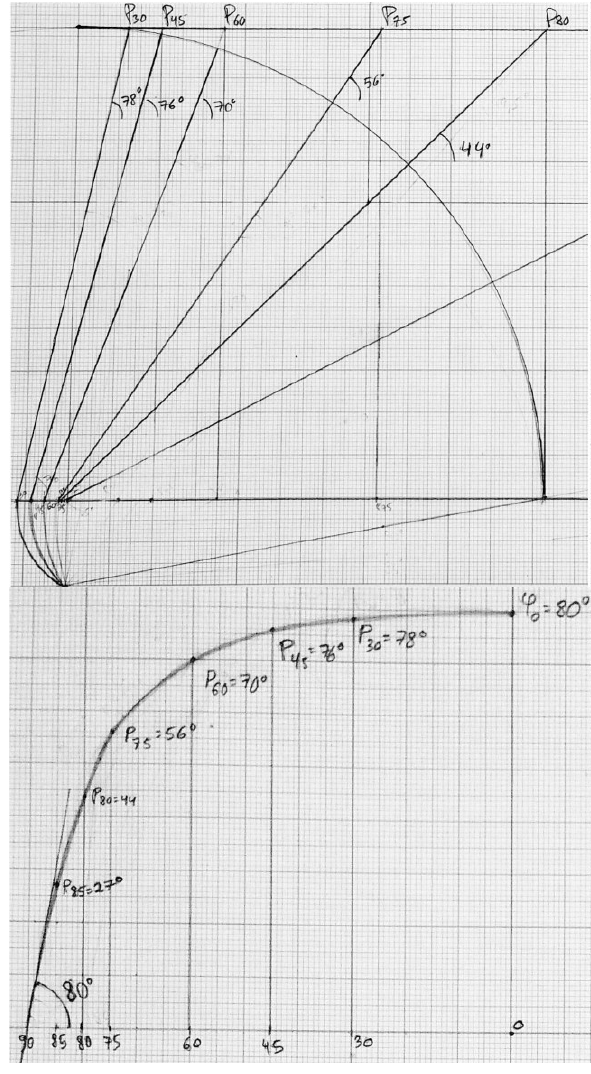
Figure 7 | Calculation with ruler, compass and protractor (top), of one half of the line (0, 80º, 0)